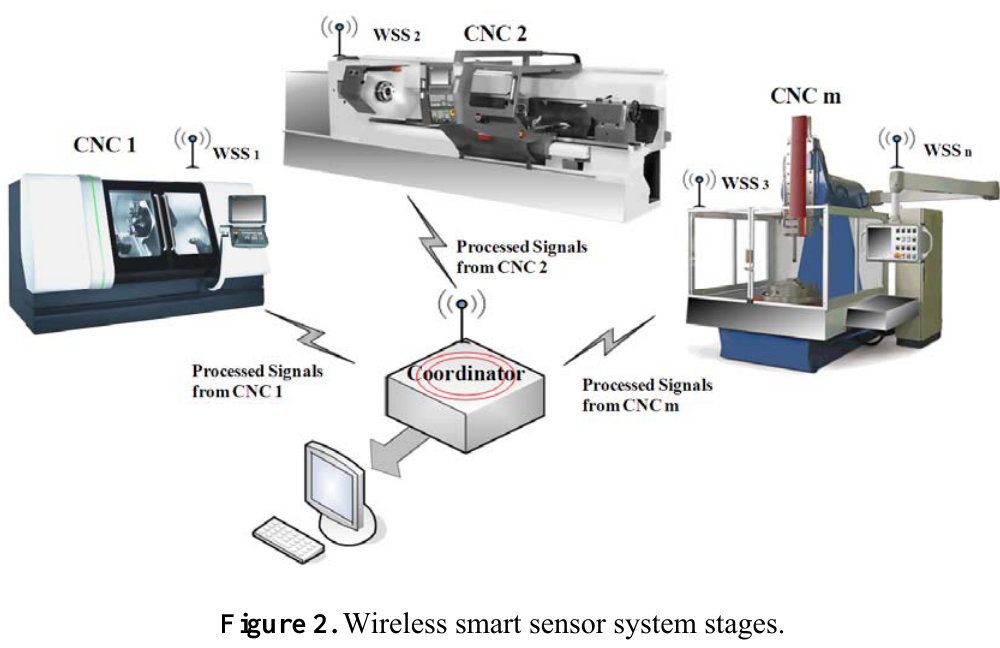
Figure 1. General block diagram of the smart sensor network.